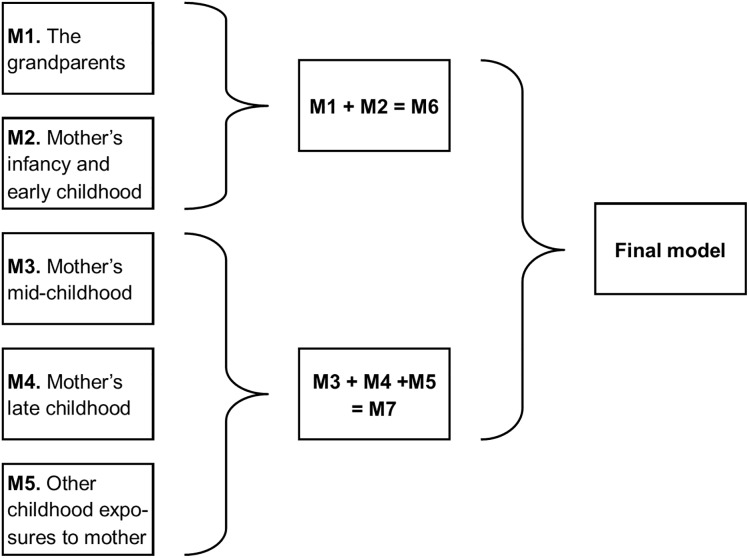
Structure of the analysis of the exposures to the maternal line.